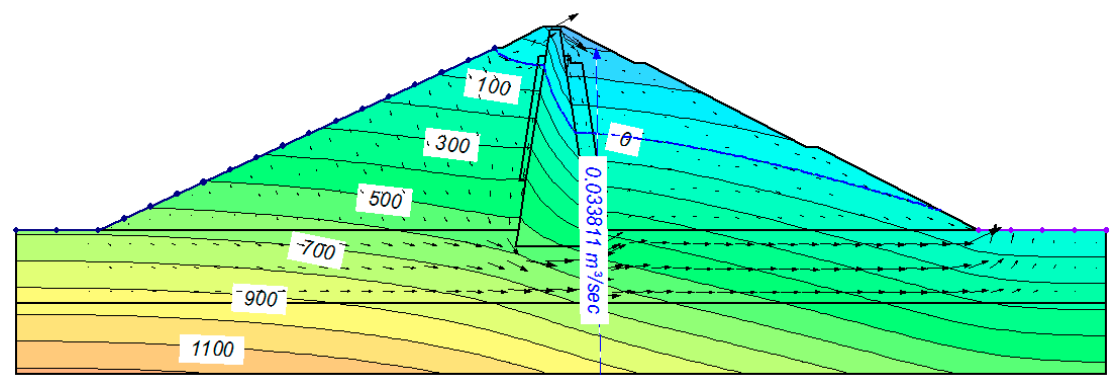
Figure 4. Pore water pressure and seepage counters.